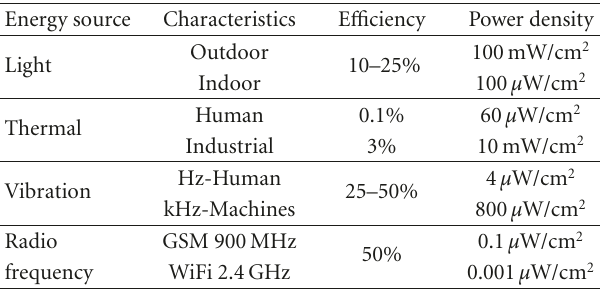
Table 1: Power densities of typical energy